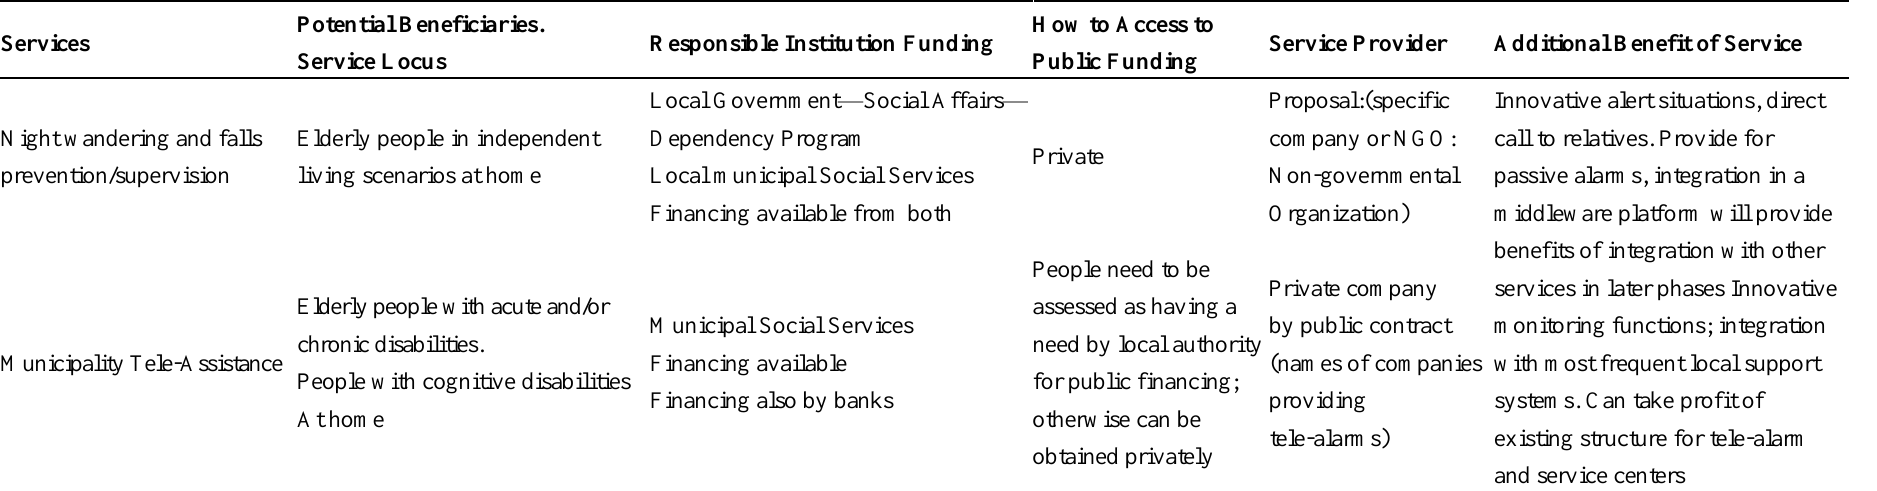
Table 13. Analysis of interaction with existing